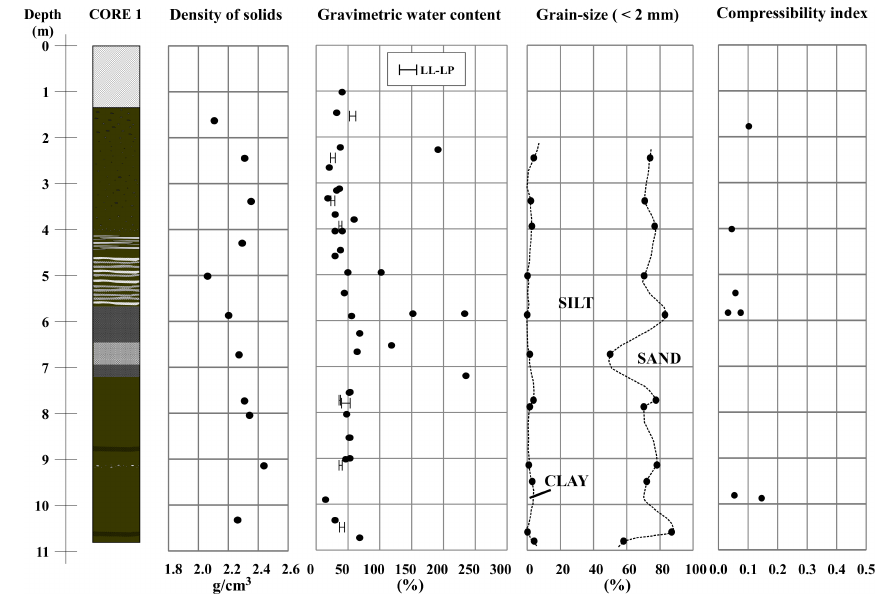
Figure 4. Core one and some of its geotechnical properties. LL-LP represents the values of liquid and plastic Atteberg limits.